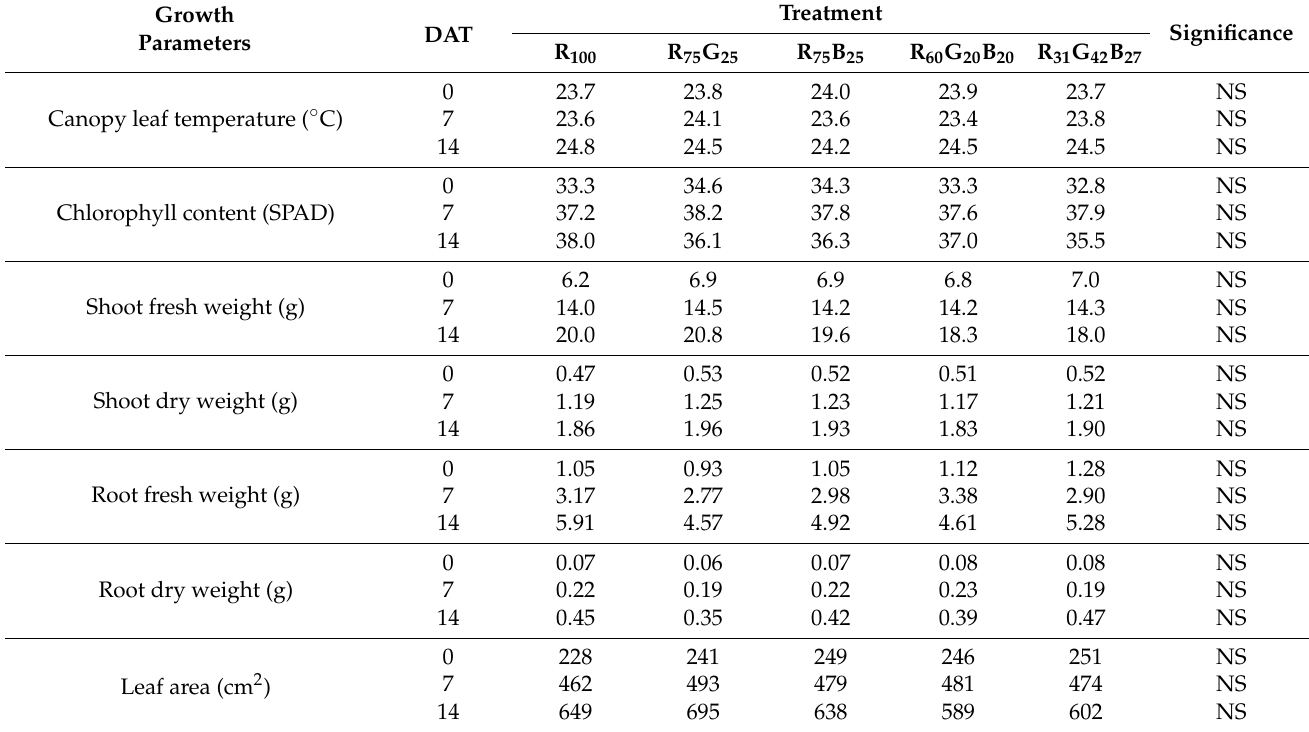
NS indicates non-significance at p < 0.05 ( n =